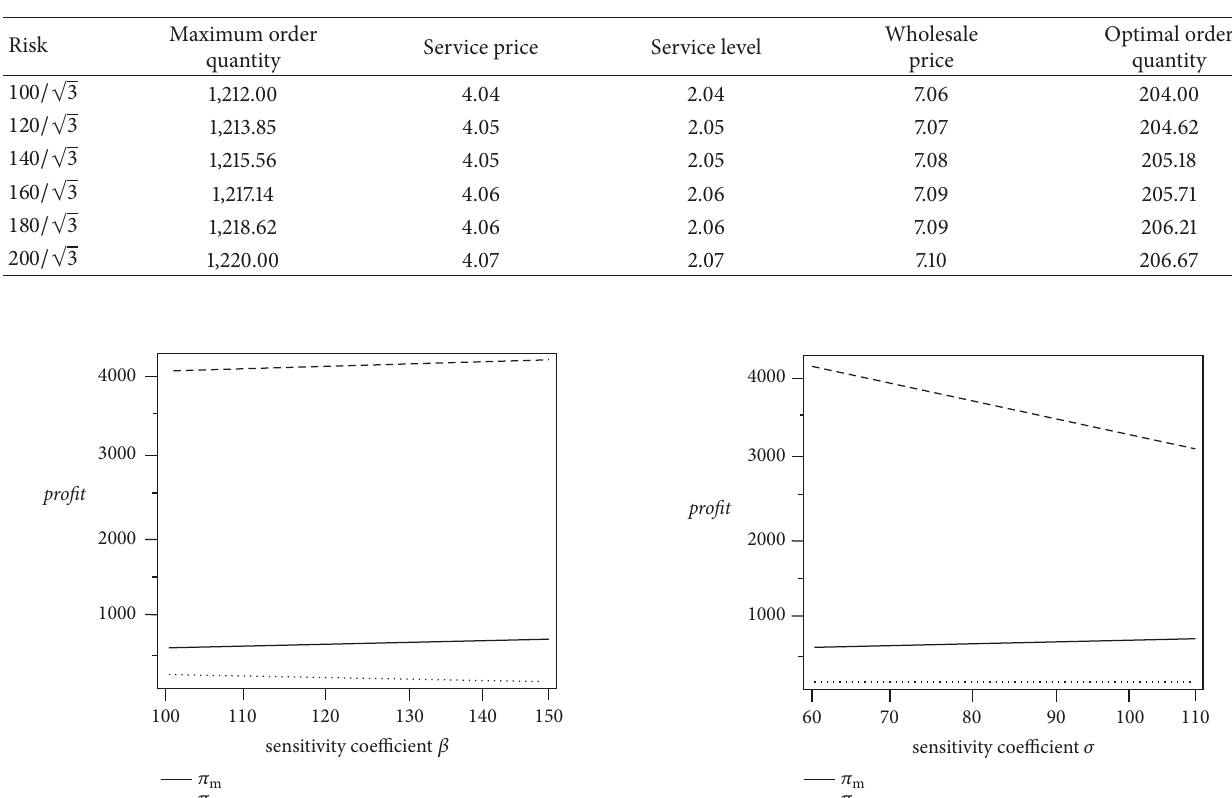
Table 5: The effect of the market risk parameter on the supply chain members’ decisions.